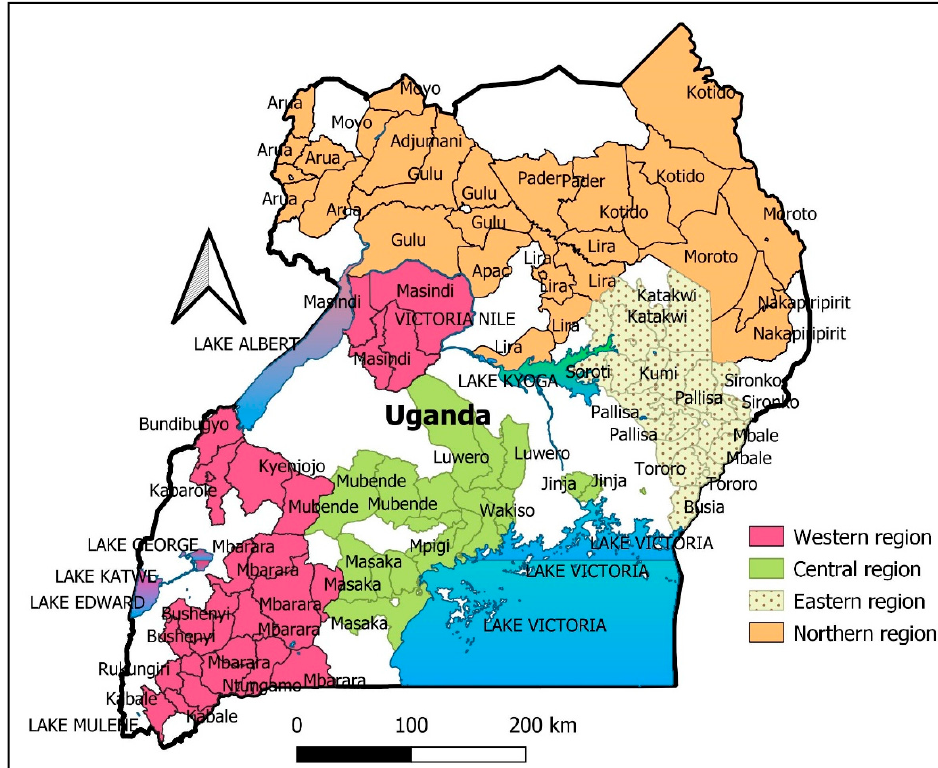
Figure 1. Location of healthcare centers surveyed in the study area by region. In total, participants were based at medical facilities in 46 districts. In particular, 39% of participants came from the central region (101/260), 28% eastern region (72/260), 10% northern region (25/260), and 24% from the western region (62/260). Further individual district demographics indicated more males participated in the study (Supplement File S1).